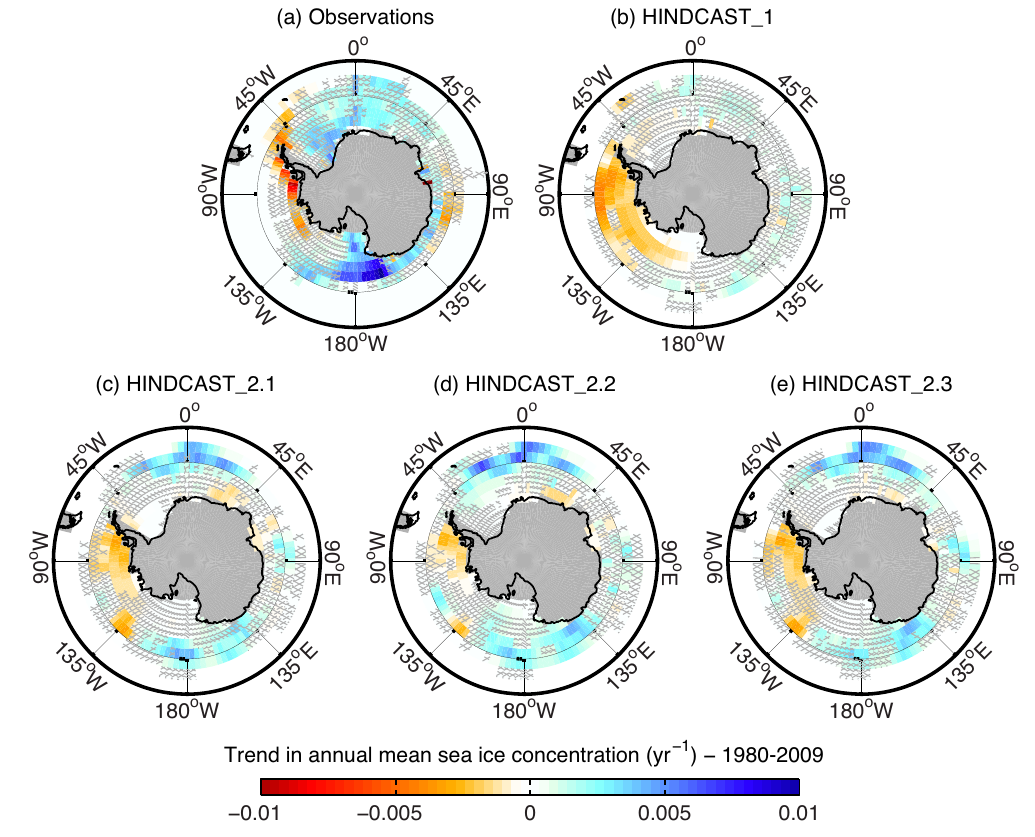
Figure 8. Trend in yearly mean sea ice concentration between 1980 and 2009, for (a) the observations (Comiso, 1999) and (b, c, d, e) the four hindcast simulations initialised on 1 January 1980 through data assimilation (see Table 1 for details). Hatched areas highlight the grid cells where the trend is not significant at the 99% level. The shaded grey areas correspond to the land mask of the ocean